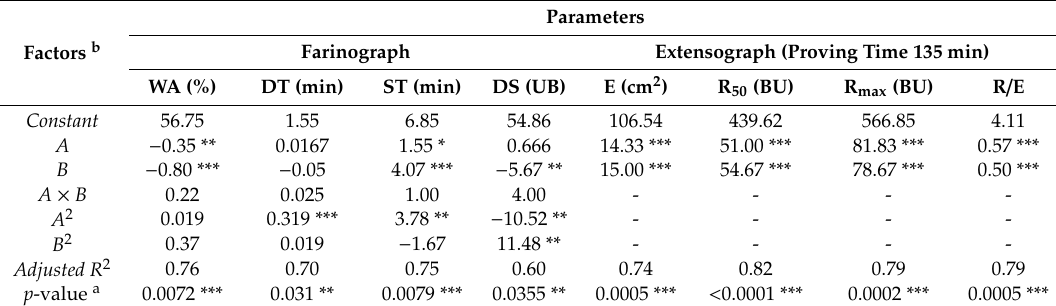
Table 2. E ff ects of independent variables, expressed as their corresponding coe ffi cients on the predictive models for dough rheological properties during the mixing of KCl–NaCl mixtures.